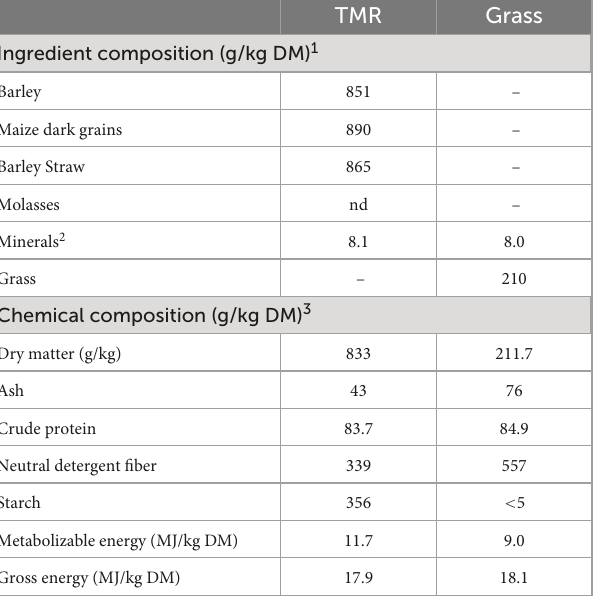
TABLE 1 Ingredients and chemical composition of two extreme offered diets fresh cut grass (Grass) and high concentrate (TMR) based.